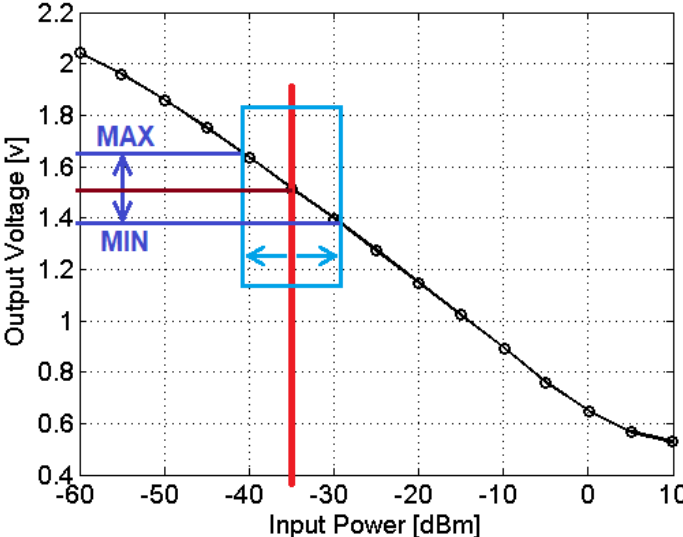
Figure 11. Response curve of the Mini-Circuits ZX95-625+ power detector [28].